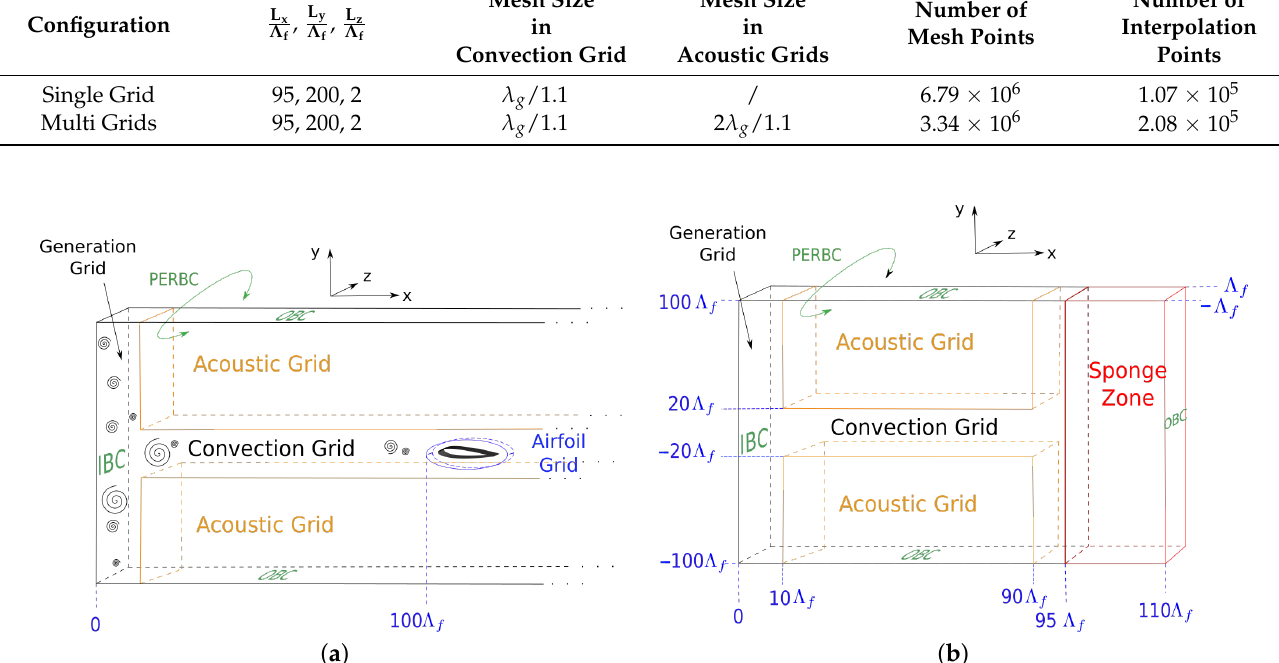
Figure 5. Schematics of the Multi Grids configuration ( a ) for future airfoil computations and ( b ) for the present HIT